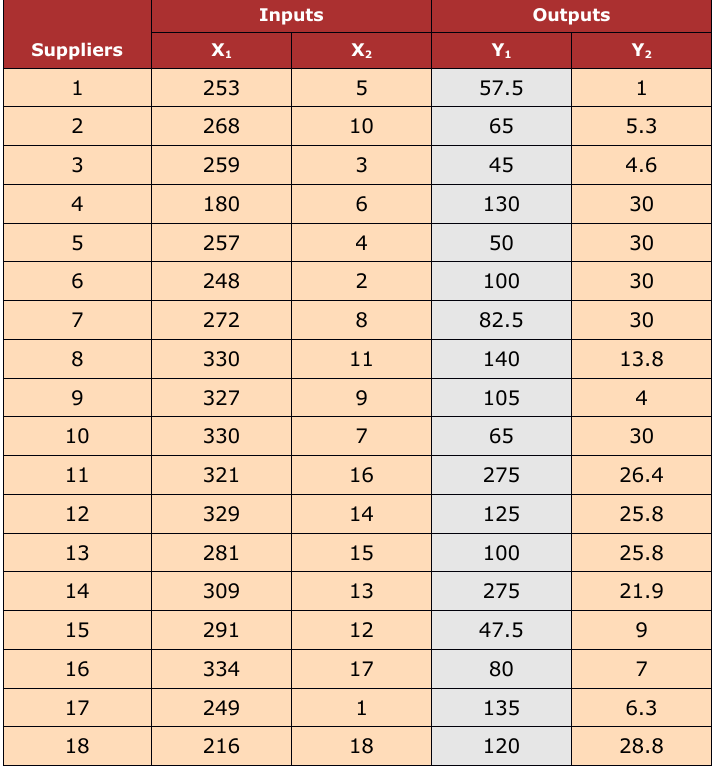
Table 3. Original values for α =